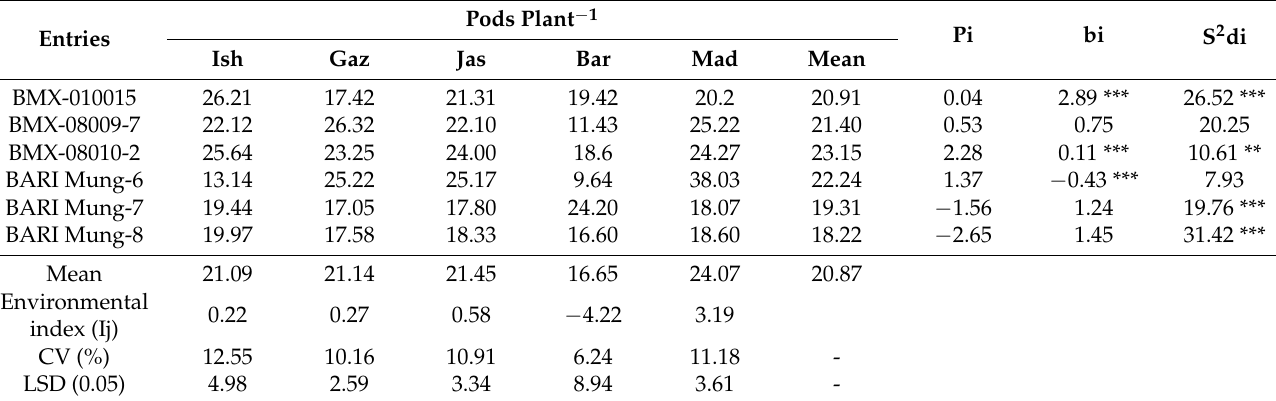
CV (%) ** = Significant at p ≤ 0.01; *** = Significant at p ≤ 0.001; Ish = Ishurdi; Gaz = Gazipur; Jas = Jashore; Bar = Barishal; Mad = Madaripur; CV = Coefficient of variation; LSD = Least significant difference, Pi = Phenotypic index; bi = Regression coefficient; S 2 di = Deviation from regression. In the case of the 100-grain weight, BARI Mung-7 showed the maximum grain weight at Ishurdi, Gazipur, Barishal, and Madaripur (Table 7). Besides, considering mean values, Barishal location showed the negative Ij, while Madaripur was at the higher end. The